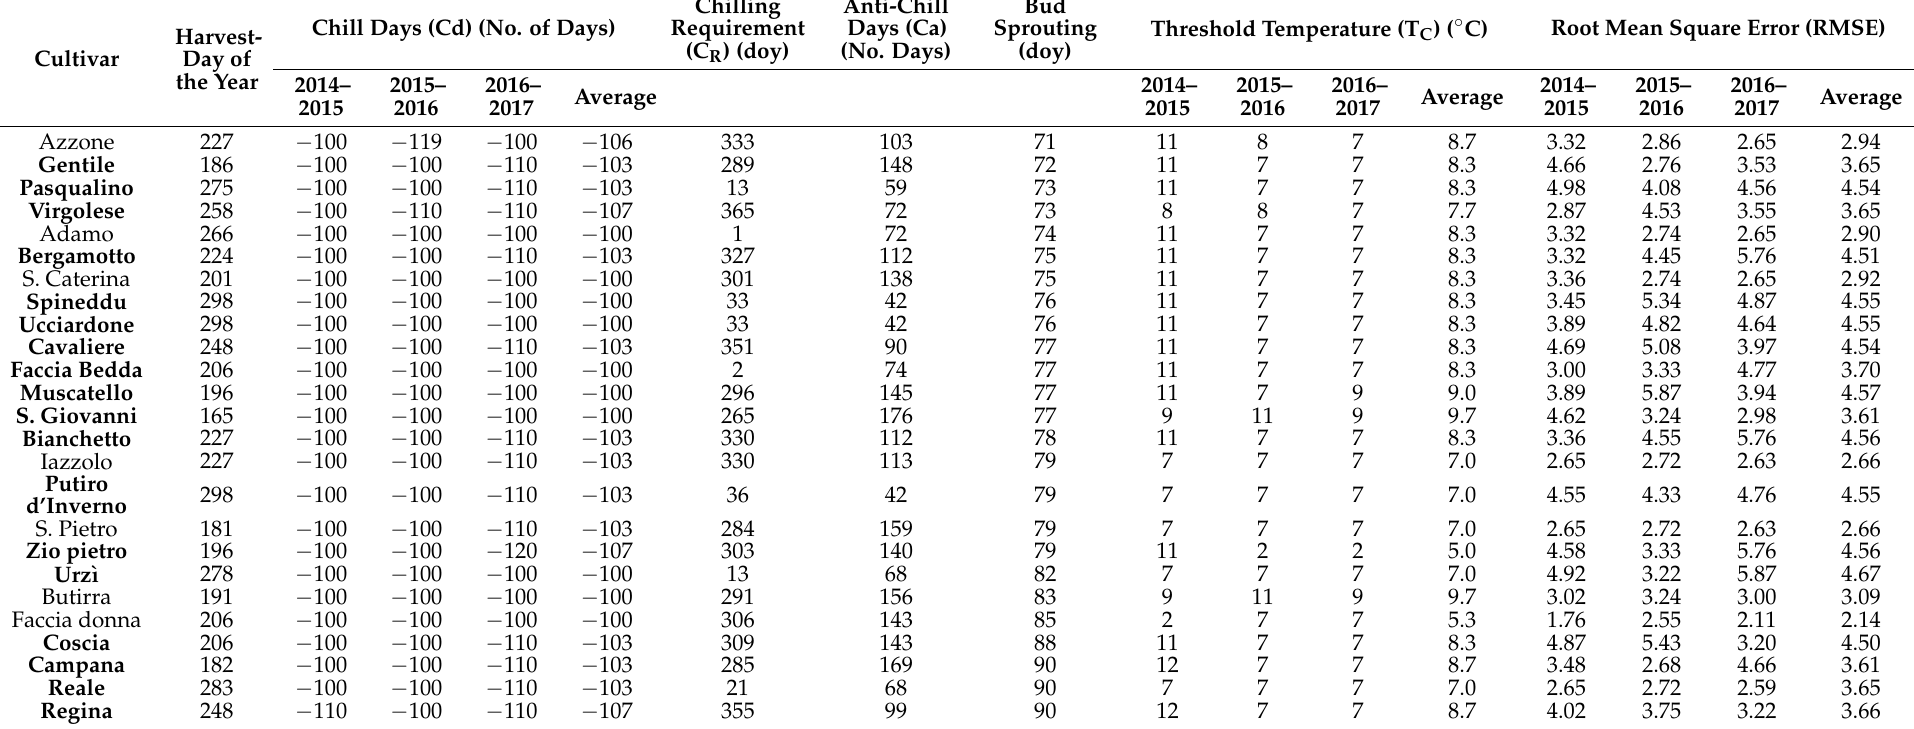
Table 2. Main phenological stages employed in the Chill Day model for the pears cultivated at the experimental field 1 (10 m a.s.l.). Rows were ordered according to the bud sprouting data. For each accession, harvest date, Chill Days, chilling requirement, antichill days, bud sprouting date, threshold temperatures and root mean square error are reported. Chill days, threshold temperatures and root mean square error are presented both for the three years tested and as average values. Harvest date refers to the previous year compared to the